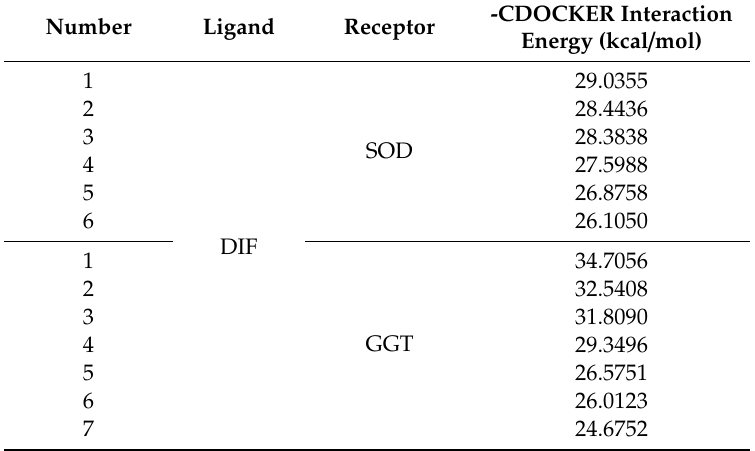
Table 1. CDOCKER interaction energy values of the binding sites of DIF to SOD and GGT proteins.